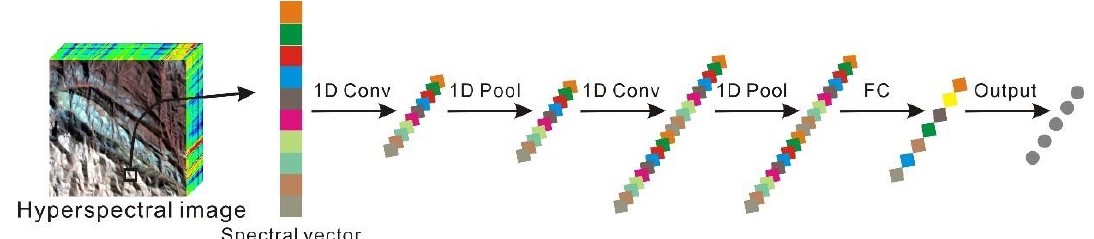
Figure 7. The 1D CNN structure for hyperspectral remote sensing data classification.